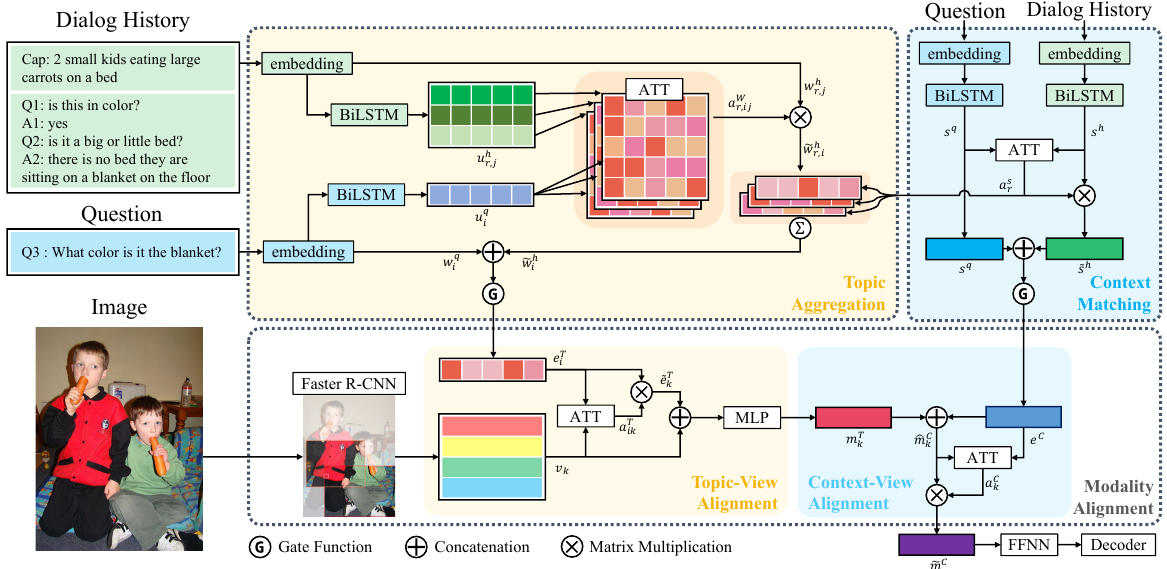
Figure 2. Model architecture of Multi-View Attention Network (MVAN). Bi-Directional Long Short-Term Memory (BiLSTM) layers for the question (blue) and the dialog history (green) are shared in the Topic Aggregation Module and Context Matching Module,